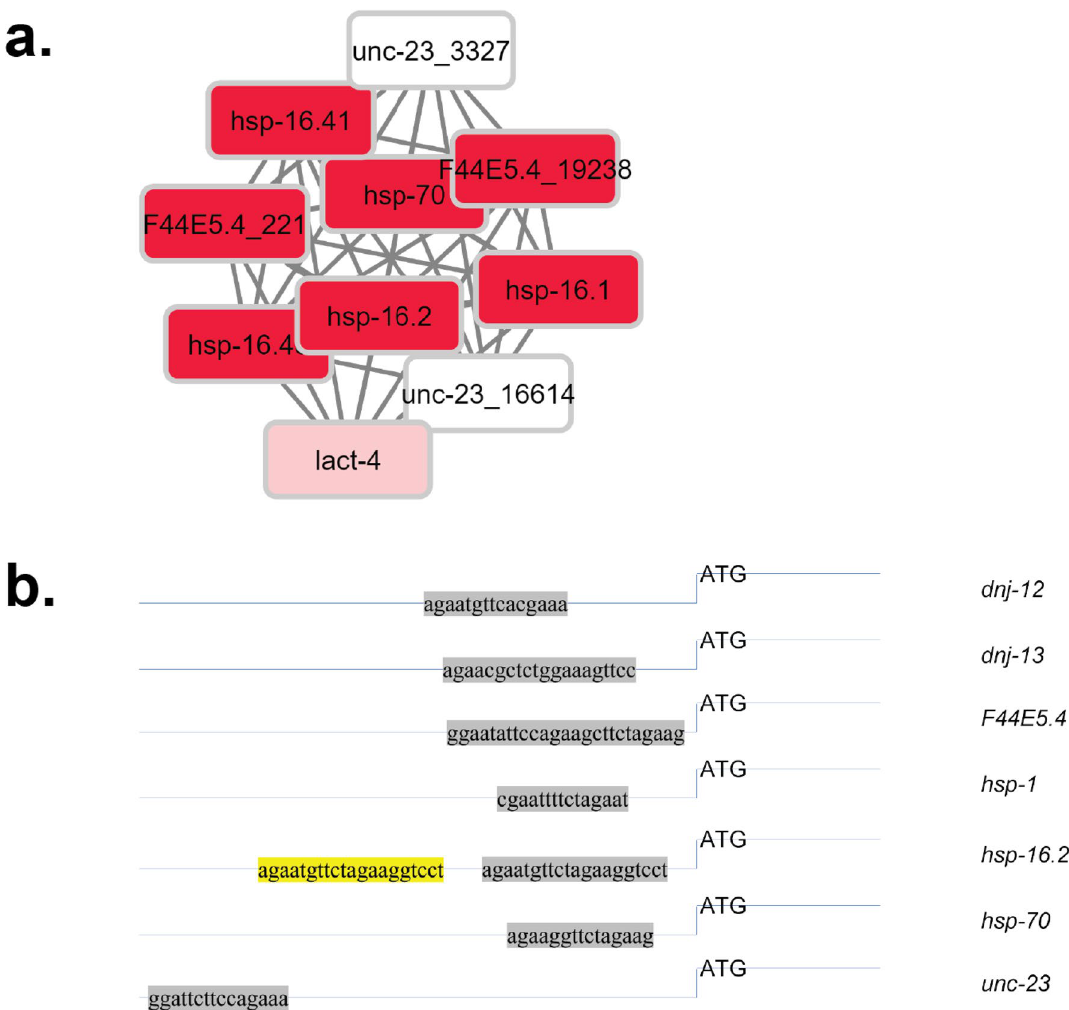
Figure 1. Determined highly induced coexpression cluster and utilized promoter regions. ( a ) The highly induced clique of the genome clustered in 307 expression groups derived from public expression experiments. The color code reflects the heat-shock response as determined by Wang et al. (GSE2862) 31 . The highly induced cluster is enlarged for better visualization, while the whole clique map of the genome can be found in Supplemental Fig. 1. ( b ) Promoter region of inducible and non-inducible chaperones, relative to the ATG start codon.